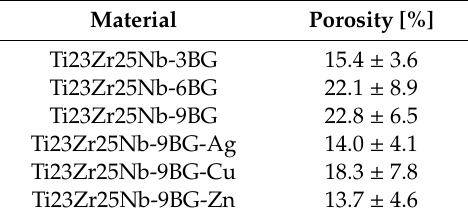
Table 3. Porosities calculated with the use of optical micrographs and histograms in GIMP software. Material Porosity